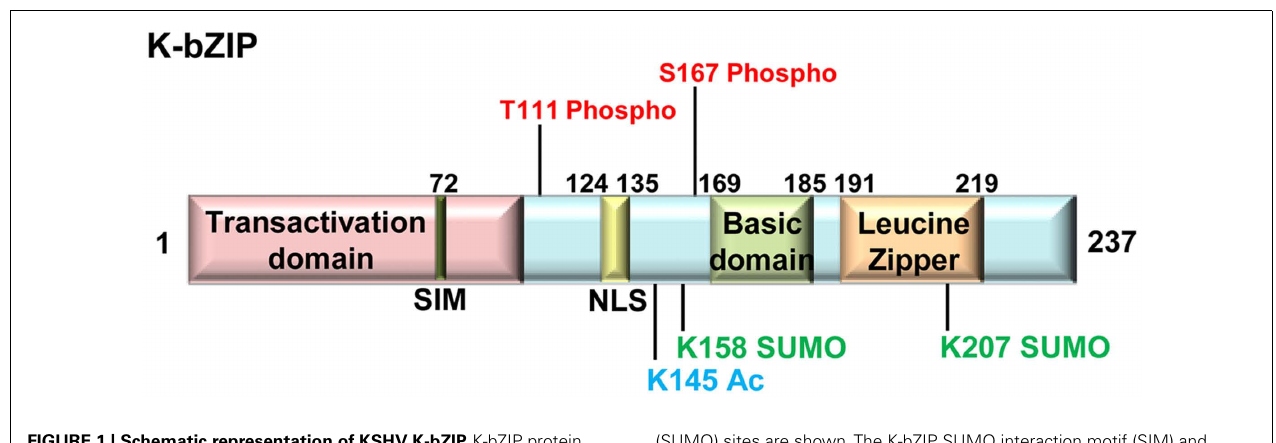
FIGURE 1 | Schematic representation of KSHV K-bZIP. K-bZIP protein and its post-translational modification sites as discussed in the text are depicted. Phosphorylation (Phospho), acetylation (Ac), and sumoylation